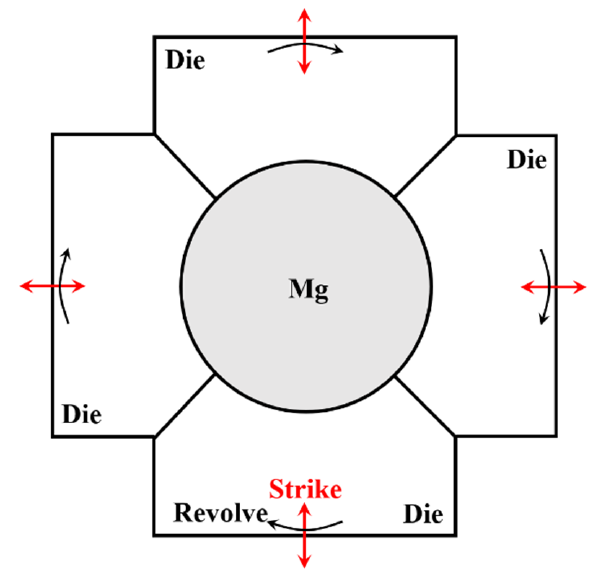
Figure 1. Schematic representation of rotary swaging. Table 2. The same accumulated deformation degree of homogenized sample (HS) and extruded samples with extrusion ratios of 9 (E9S) and 25 (E25S), respectively.